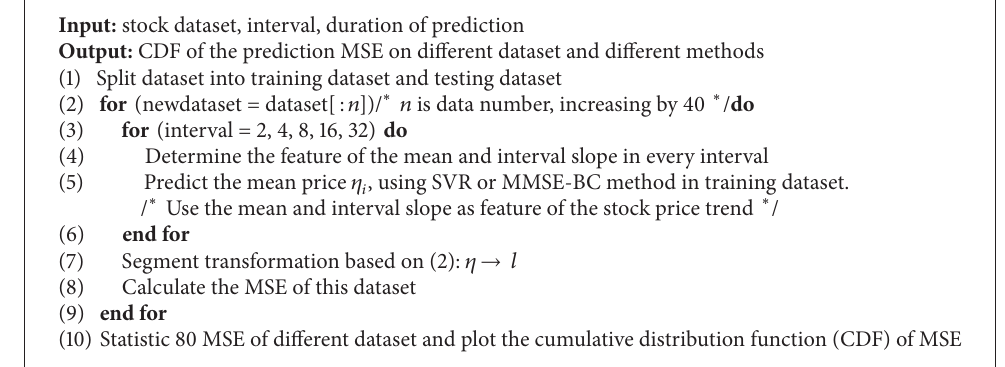
Algorithm 1: Stock price trend prediction model.